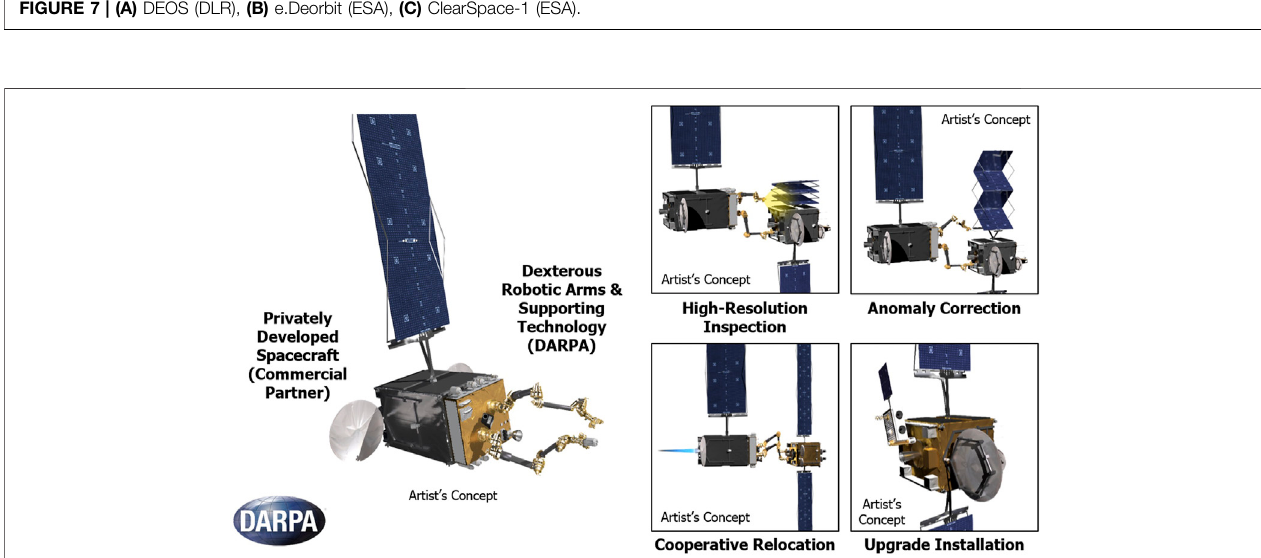
FIGURE 8 | Robotic servicing vehicle (RSV) and envisioned missions (Parrish,